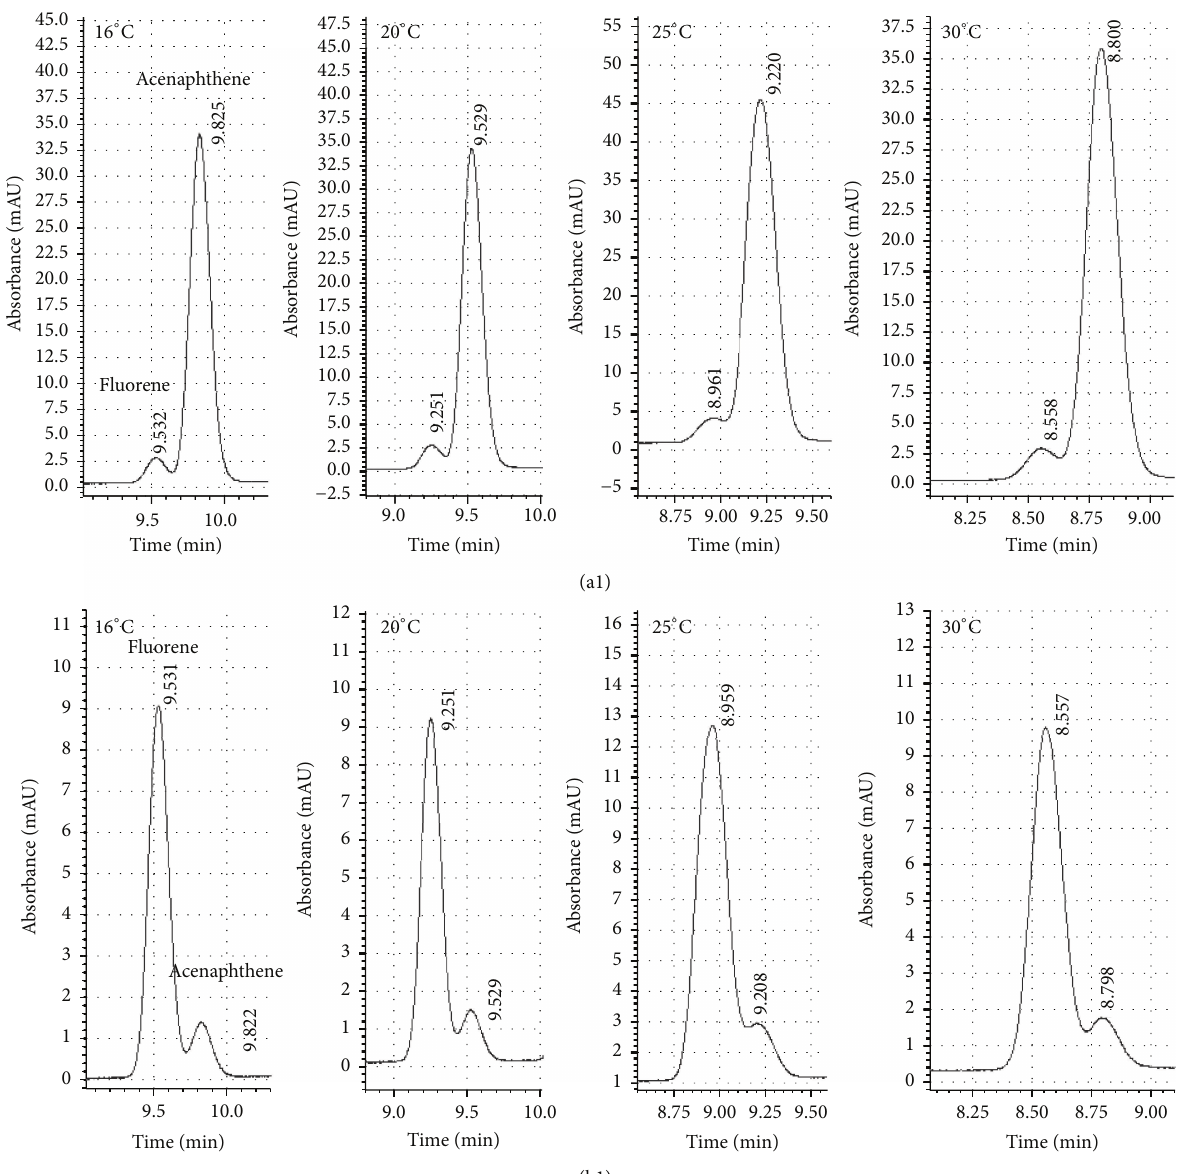
Figure 4: Effect of the temperature on the separation of fluorene and acenaphthene using the Kinetex column; (a1) at 227 nm; (b1) at 261